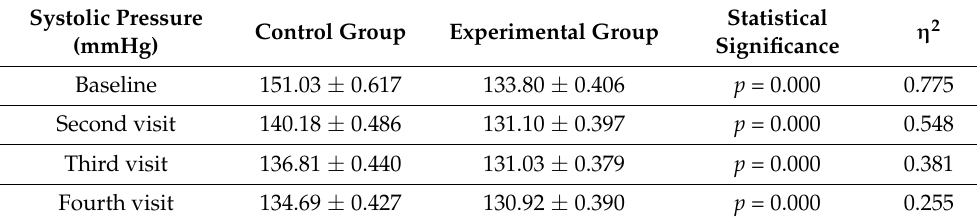
Table 2. Values of systolic blood pressure in the study population. Results are presented as mean ± standard means of errors (X ± SEM) in control and experimental groups. Statistical difference was confirmed by Mann–Whitney U test. An eta-squared ( η 2 ) value reflects the strength or magnitude related to a main or interaction effect.